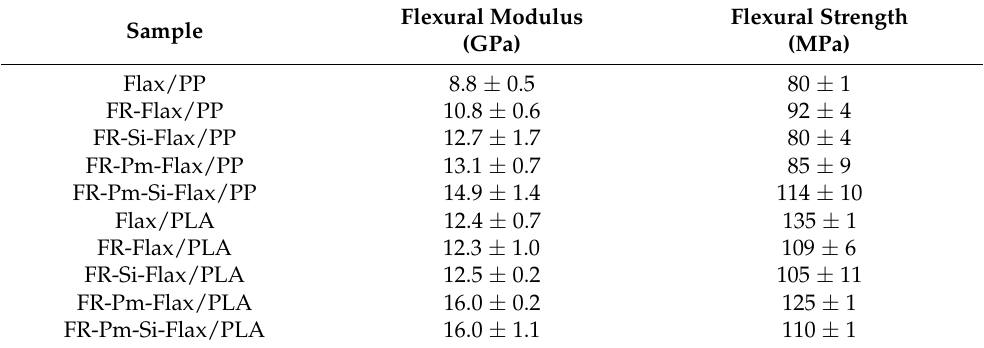
Table 6. Flexural properties of FR (GUP), silane and plasma-treated flax/PP and flax/PLA fabrics as laminates.